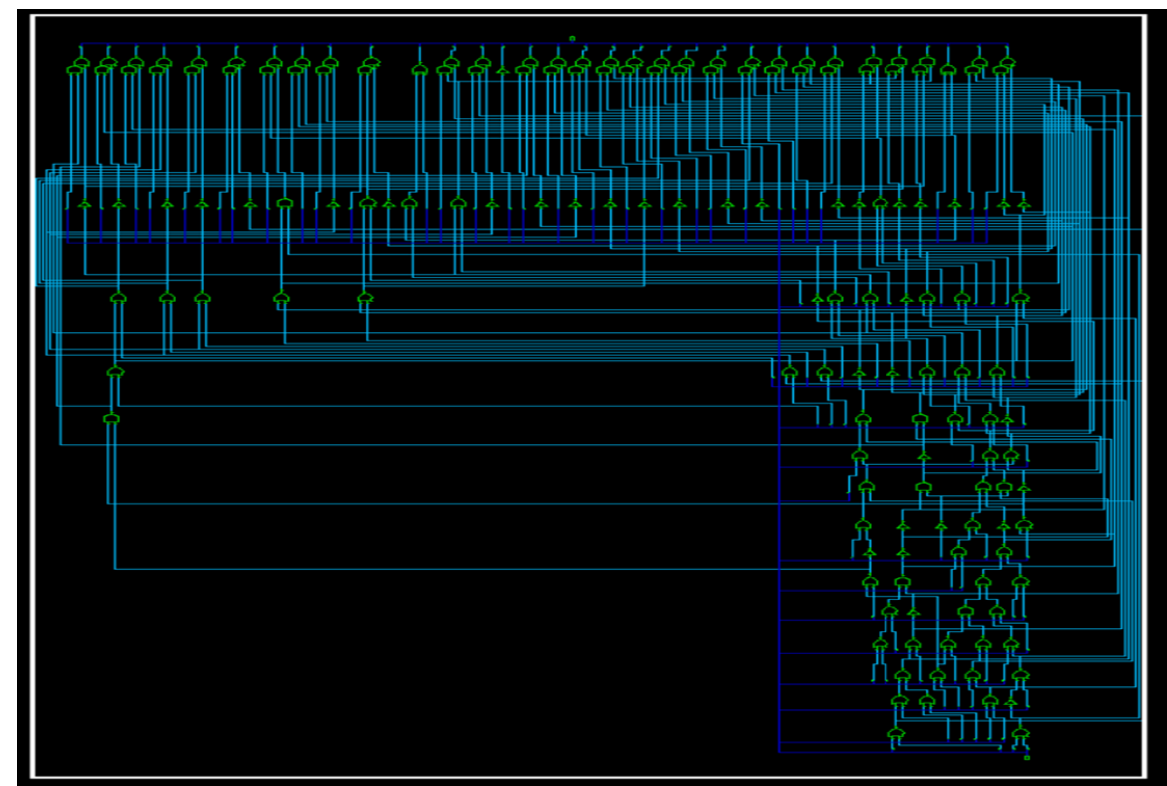
Figure 20. Circuit for the Base64 encoder generated through Verilog.